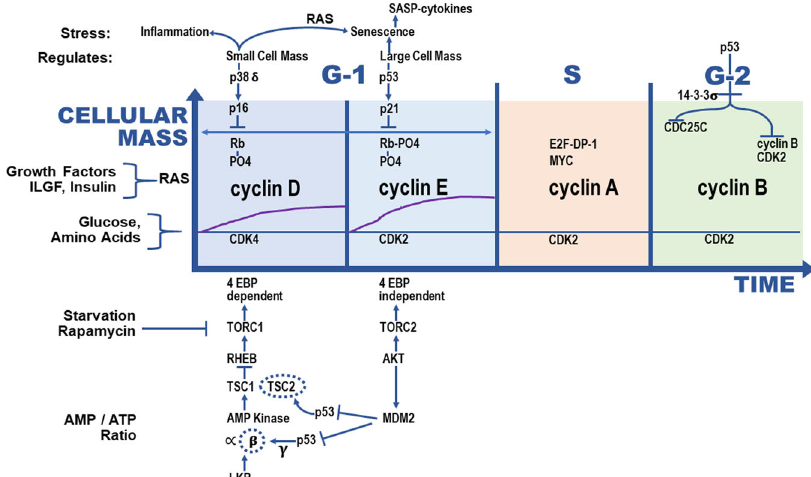
Fig. 3 Genes involved in serous ovarian cancer in the G-1 phase of the cell cycle: the G-1 phase of the cell cycle can be divided up into cyclin D-CDK4/6 early events and cyclin E-CDK2 later events. The inhibitors of these protein kinase activities, p38 and p16 for cyclin D and p53 and p21 for cyclin E, are shown above the cyclin D and E panels. The activating pathways for cyclin D (TORC1) and cyclin E (TORC2) are shown below these panels. The mutational loss of TP53 and the ampli fi cation of cyclin E results in the loss of control of cyclin E levels and the hyper-ampli fi cation of centrosome numbers destabilizing the copy number control of chromosome numbers (aneuploidy) and gene copy numbers. Serous ovarian cancers commonly have KRAS , MYC , and AKT1 genes or chromosome ampli fi cations and overexpression. The CDKN1A gene which codes for p21 is not mutated suggesting that it has additional functions required elsewhere for viability or that additional functions of p53 must be lost for ovarian cancers. Every gene highlighted in this fi gure can be found genetically altered in a cancer of other tissue